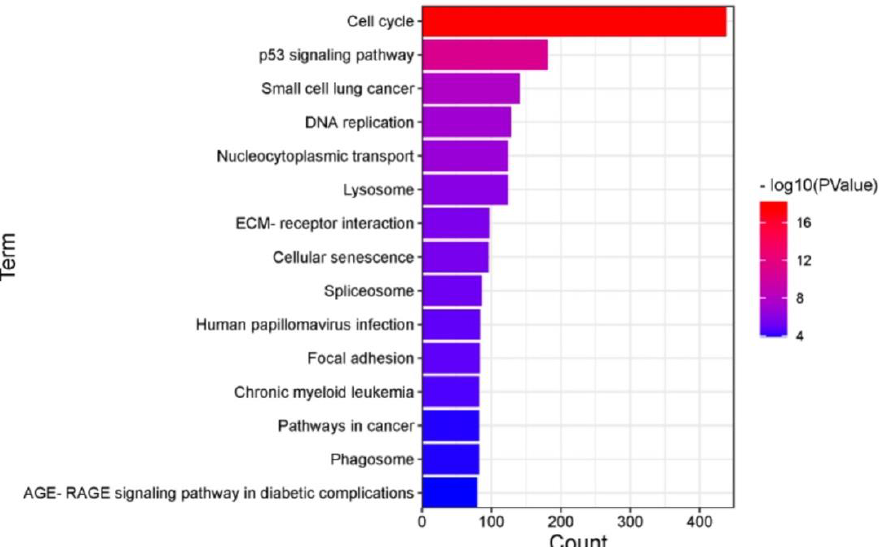
Figure 6. KEGG pathway enrichment analysis of differential genes after radiotherapy in GBM. In the GEO database, 12 samples (radiotherapy-treated in GBM cells) were analyzed. Differential genes after RT were analyzed using DAVID and